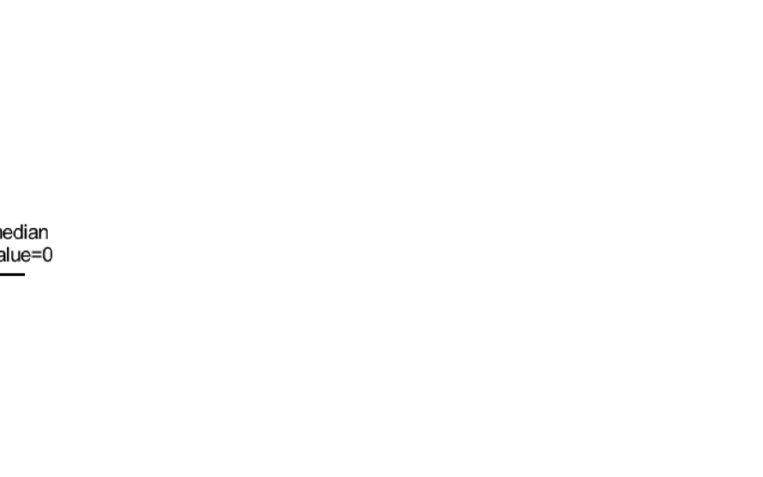
Figure 4. “Callosal angle” sub-score differed significantly between tap test responders and non- responders ( p = 0.03). The median values and the range of “callosal angle” sub-sore values in the two groups are presented in this graph.